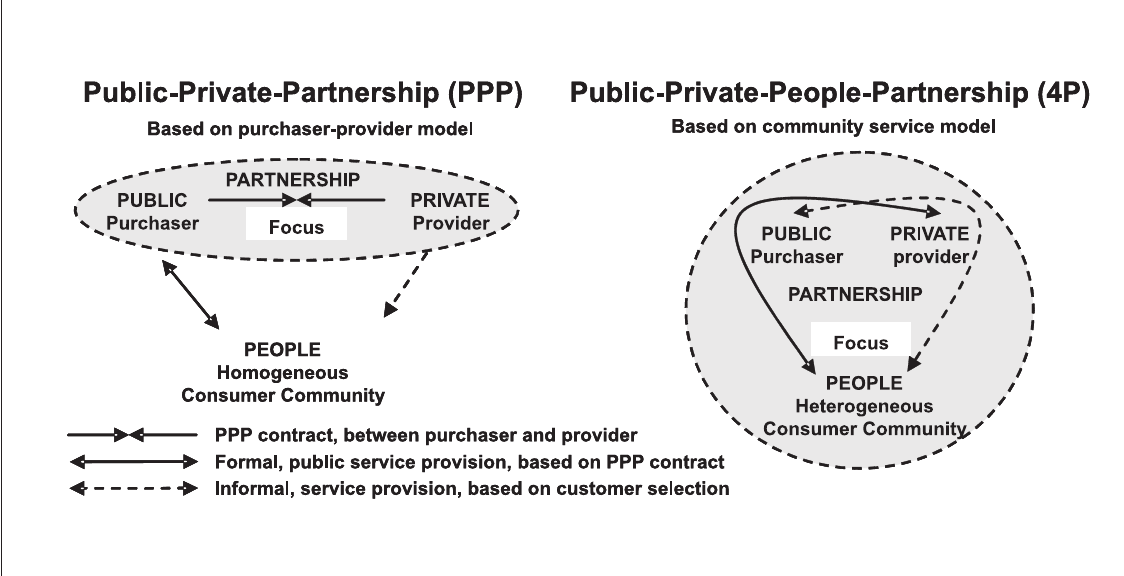
Figure 2. Building the 4th P to the